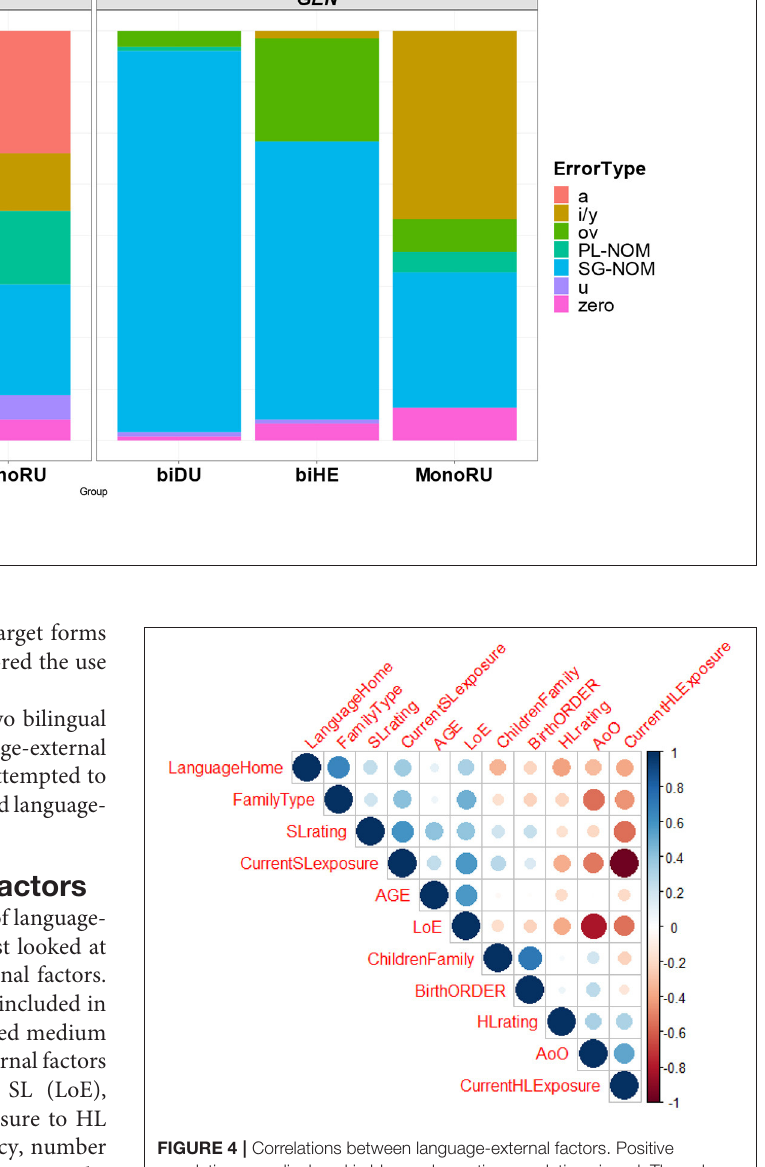
FIGURE 4 | Correlations between language-external factors. Positive correlations are displayed in blue and negative correlations in red. The color intensity and the size of the circle are proportional to the correlation coefficients. Insignificant correlations are removed from the correlational matrix ( p <